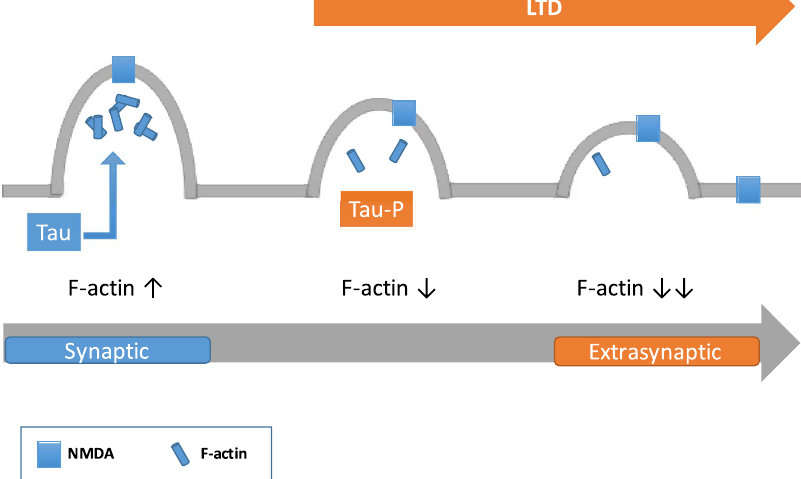
Figure 5. Tau may regulate NMDA receptor trafficking through actin depolymerization. As discussed in the text, Tau phosphorylated could facilitate F-actin depolymerization in the spine in a direct or indirect way, and as consequence of that, synapytic NMDA receptors could move to extrasynaptic regions. This effect may not take place in Tau − / −